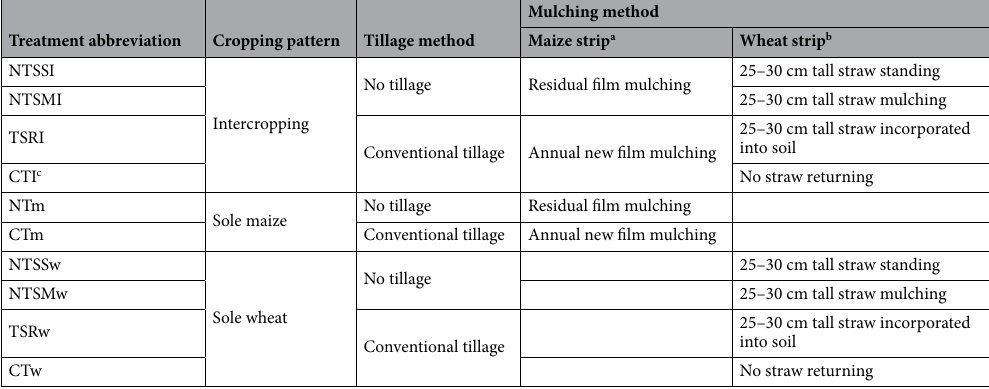
Table 4. Description of treatments. a Residual plastic mulching: e.g., 2-years film mulching: soil was mulched with new film in the previous year and the plastic was preserved with no tillage and sowing directly on the residual plastic in the following spring. Annual new film mulching: after maize harvest in the previous year, residual film was removed and soil was tilled, and in the following spring soil was mulched with new film and maize was sown. b Straw management was implemented following wheat harvest in the previous year. c Conventional intercropping treatment (CTI): wheat straw cut above the soil surface and removed it before conventional tillage in wheat strip and annual new film mulching in maize strips. Wheat straw in CTI and CTw treatment and maize straw in all treatments were removed out of fields.